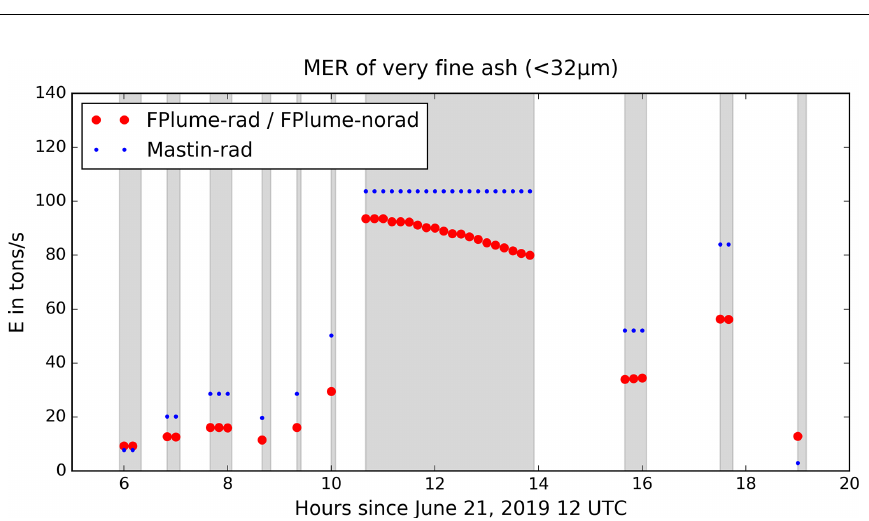
Figure 2. Mass eruption rate E for very fine ash (ts − 1 ) calculated with the FPlume MER times the very fine ash fraction from Gouhier et al. (2019) (red) and calculated with the Mastin MER times the very fine ash fraction derived in the FPlume experiment (blue). The very fine ash fraction is the same in both experiments to allow for a direct comparison of the FPlume- and Mastin-derived MER on the dispersion in the atmosphere. Active eruption phases are indicated by the gray shading. Please note that the date format in this and following figures is month day,